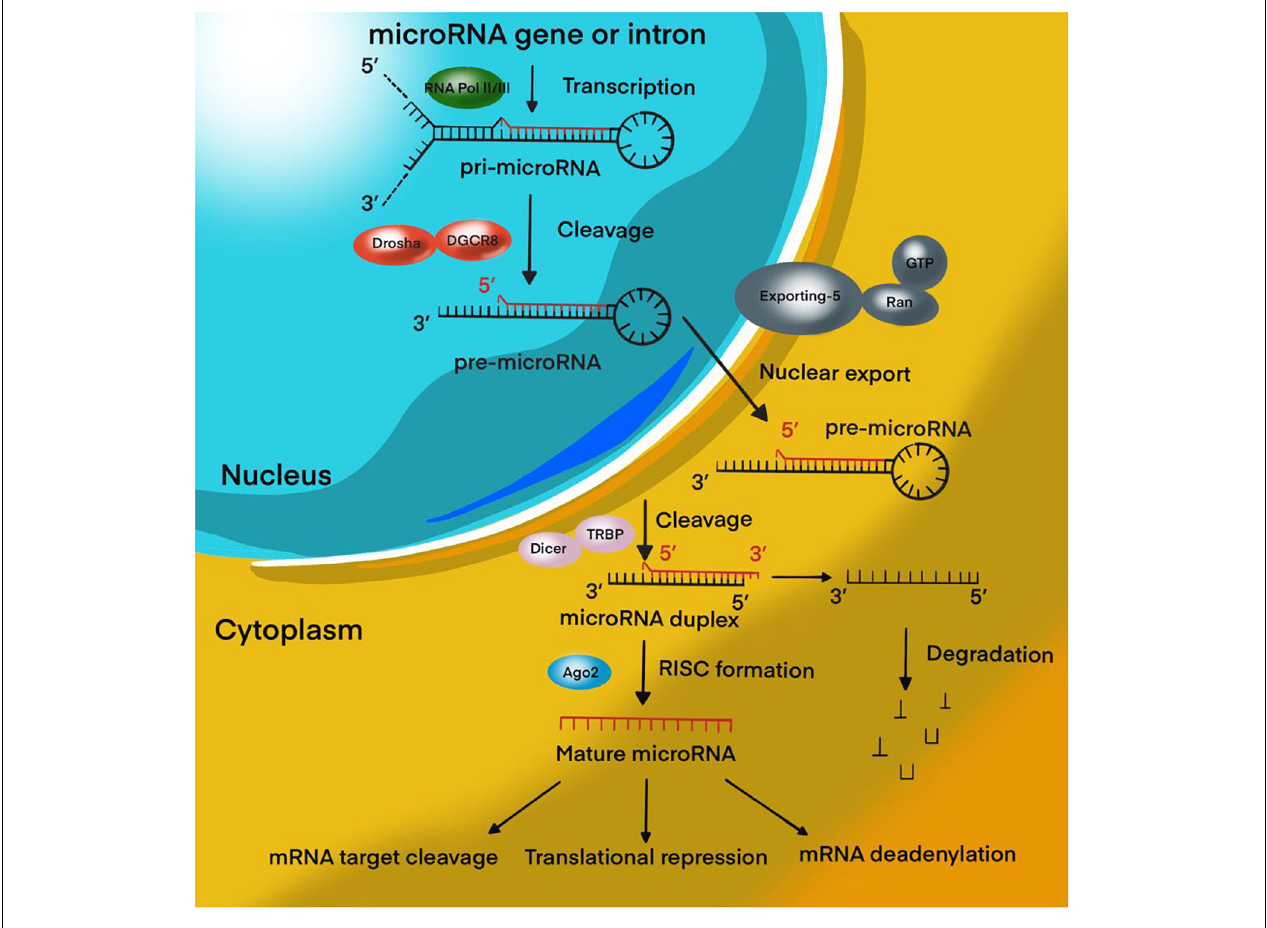
FIGURE 1 | MiRNA biogenesis pathway. Overview schematic representation of canonical miRNA biogenesis